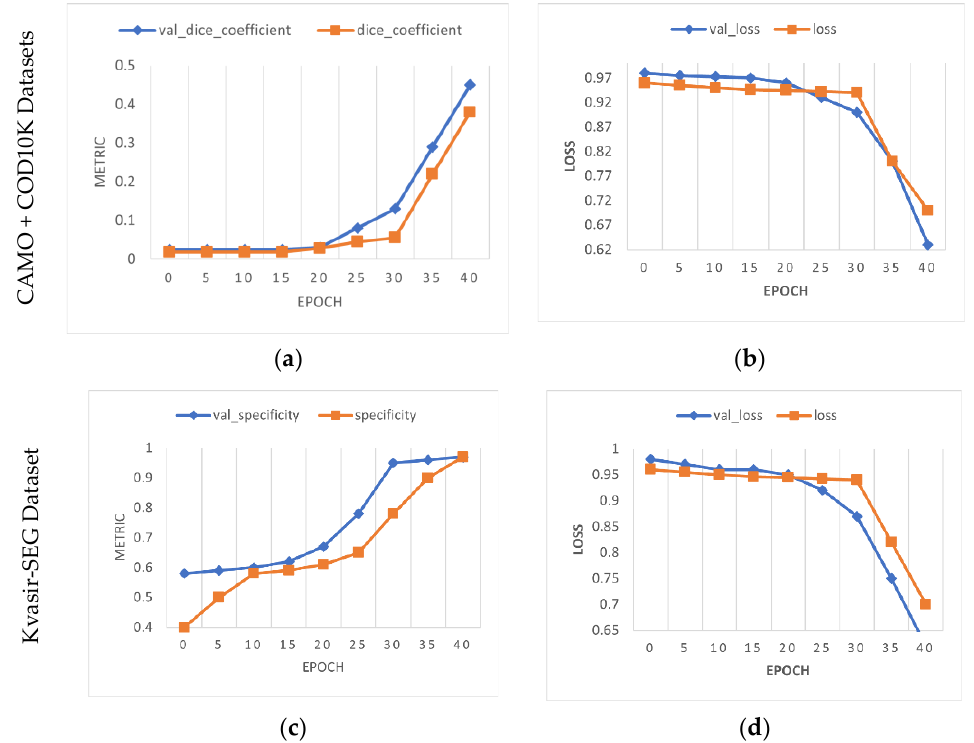
Figure 7. CAMO + COD10K, and Kvasir-SEG Datasets, Combined Experiments on training and validation dataset: ( a ) dice coefficient; ( b ) binary cross-entropy loss; ( c ) specificity; ( d ) binary cross-entropy loss.